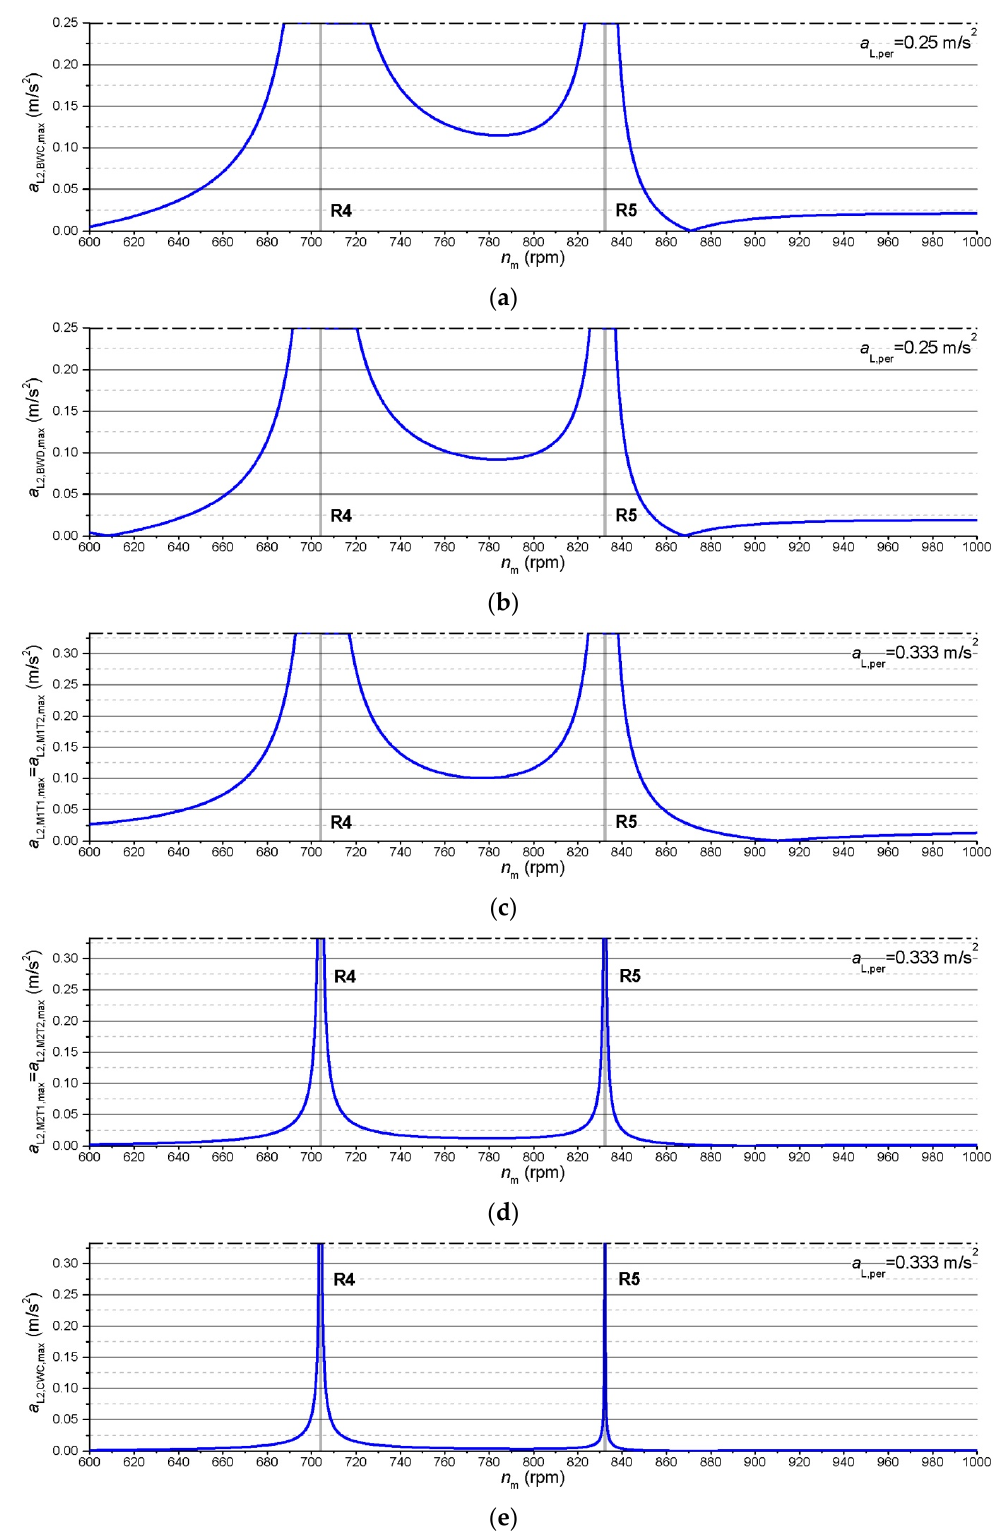
Figure 7. Response to the second harmonic of excitation—maximal lateral accelerations of the referent points of the slewing superstructure: ( a ) BWC; ( b ) BWD; ( c ) M1T1 and M1T2; ( d ) M2T1 and M2T2; ( e ) CWC.